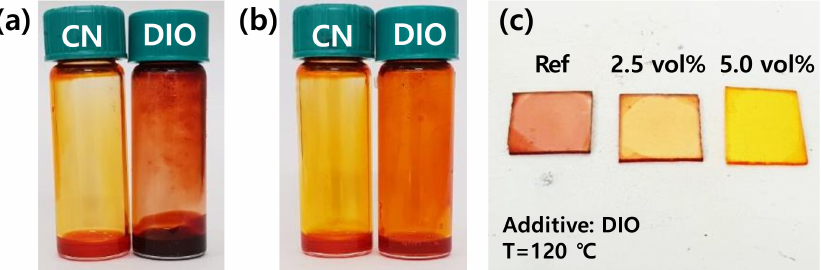
Figure 5. ( a , b ) P3HT solutions (10 mg mL − 1 ) in CN and DIO as a solvent: ( a ) at 50 ◦ C and ( b ) at 120 ◦ C. ( c ) P3HT thin films at 120 ◦ C, processed with various concentrations of